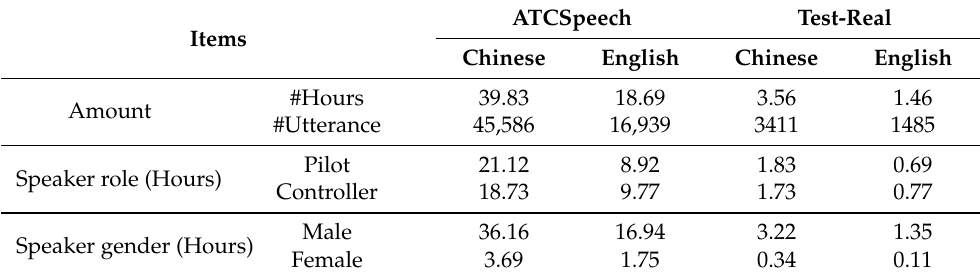
Table 1. The detailed descriptions of the ATC Speech corpus and the Test-real dataset.